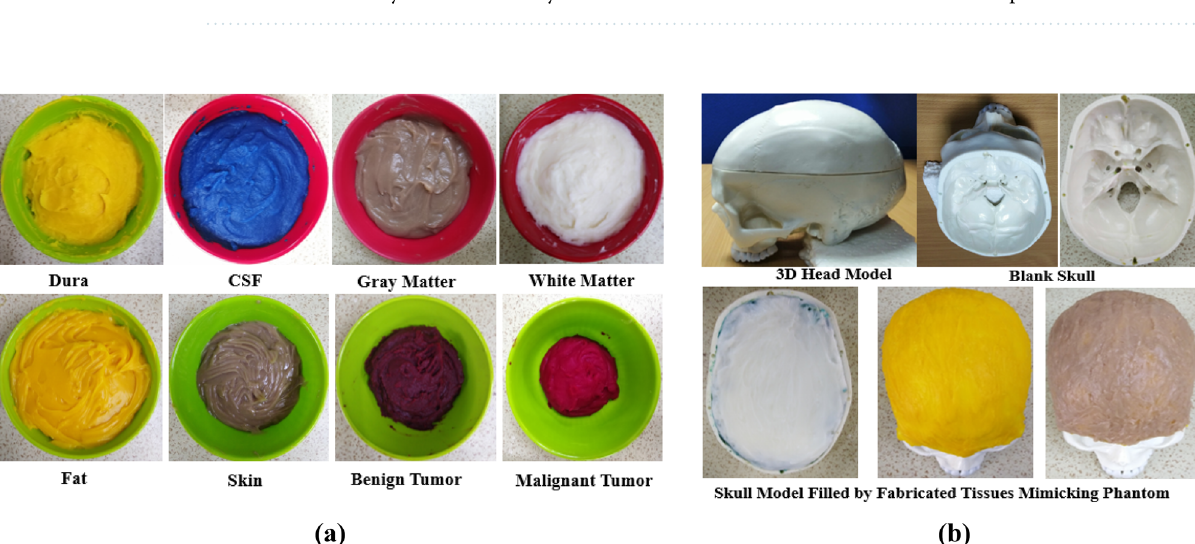
Table 6. Permittivity and conductivity of brain tissues of the human head and fabricated phantom.